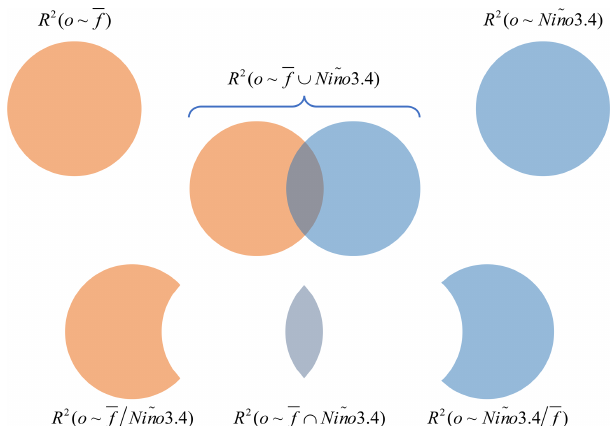
Figure 1. Venn diagram representation of the set operations of union, intersection and difference to quantify the overlapping in- formation and the two types of differing information. The different terms of information are measured by the classic coefficient of de-